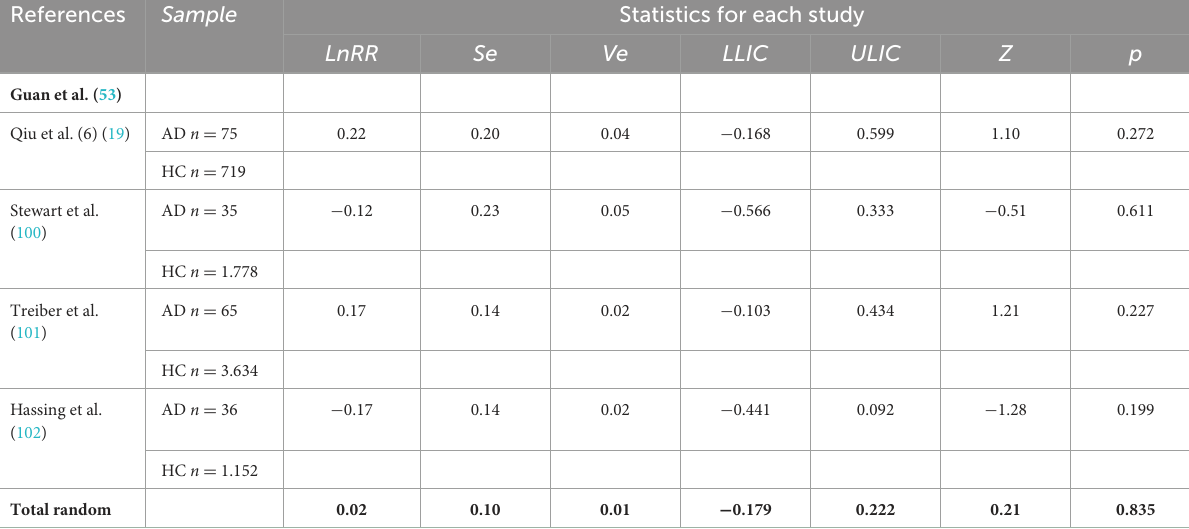
TABLE 4 Individual and pooled estimates of the association between high BP and